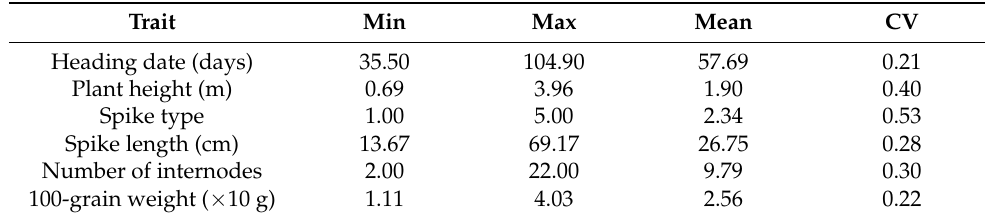
Figure 2. The analysis of phenotype. ( a – f ) The frequency distribution histogram of six traits. ( g ) The relevance of each trait. Table 1. The minimum (Min), maximum (Max), mean values (Mean), and coefficient of variation (CV) of heading date (days), plant height (m), spike type, spike length (cm), number of internodes, and 100-grain weight (g) in the population.